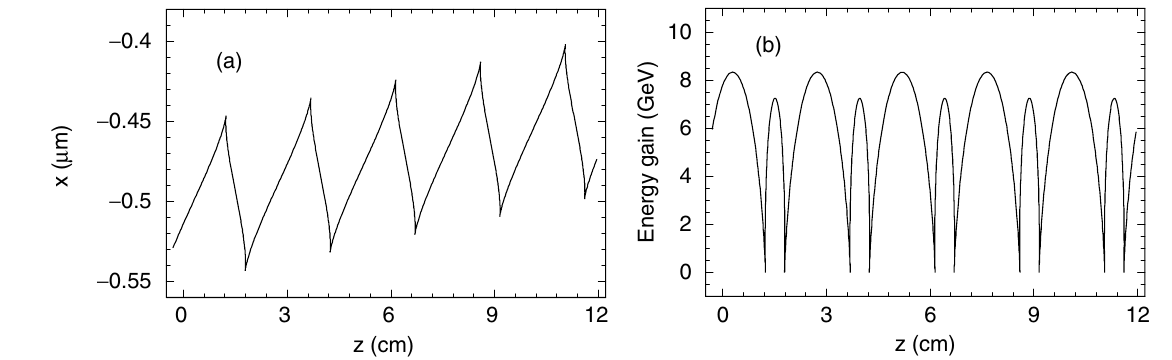
FIG. 2. (a) Electron trajectory in a plane wave field, calculated on the basis of Eq. (2). (b) Electron energy gain during interaction with the same field, calculated using Eqs. (3) and (5). The beam parameters are (cid:20) (cid:3) 1 : 056 (cid:28) m and q (cid:3) 100 . The electron (cid:3) 20 , (cid:6) (cid:3) 10 (cid:1) , and z (cid:3) (cid:2) 3 mm . Duration of interaction corresponds to five field cycles, or (cid:24) (cid:16) (cid:3) 10 (cid:21) parameters are (cid:15) i 0 0